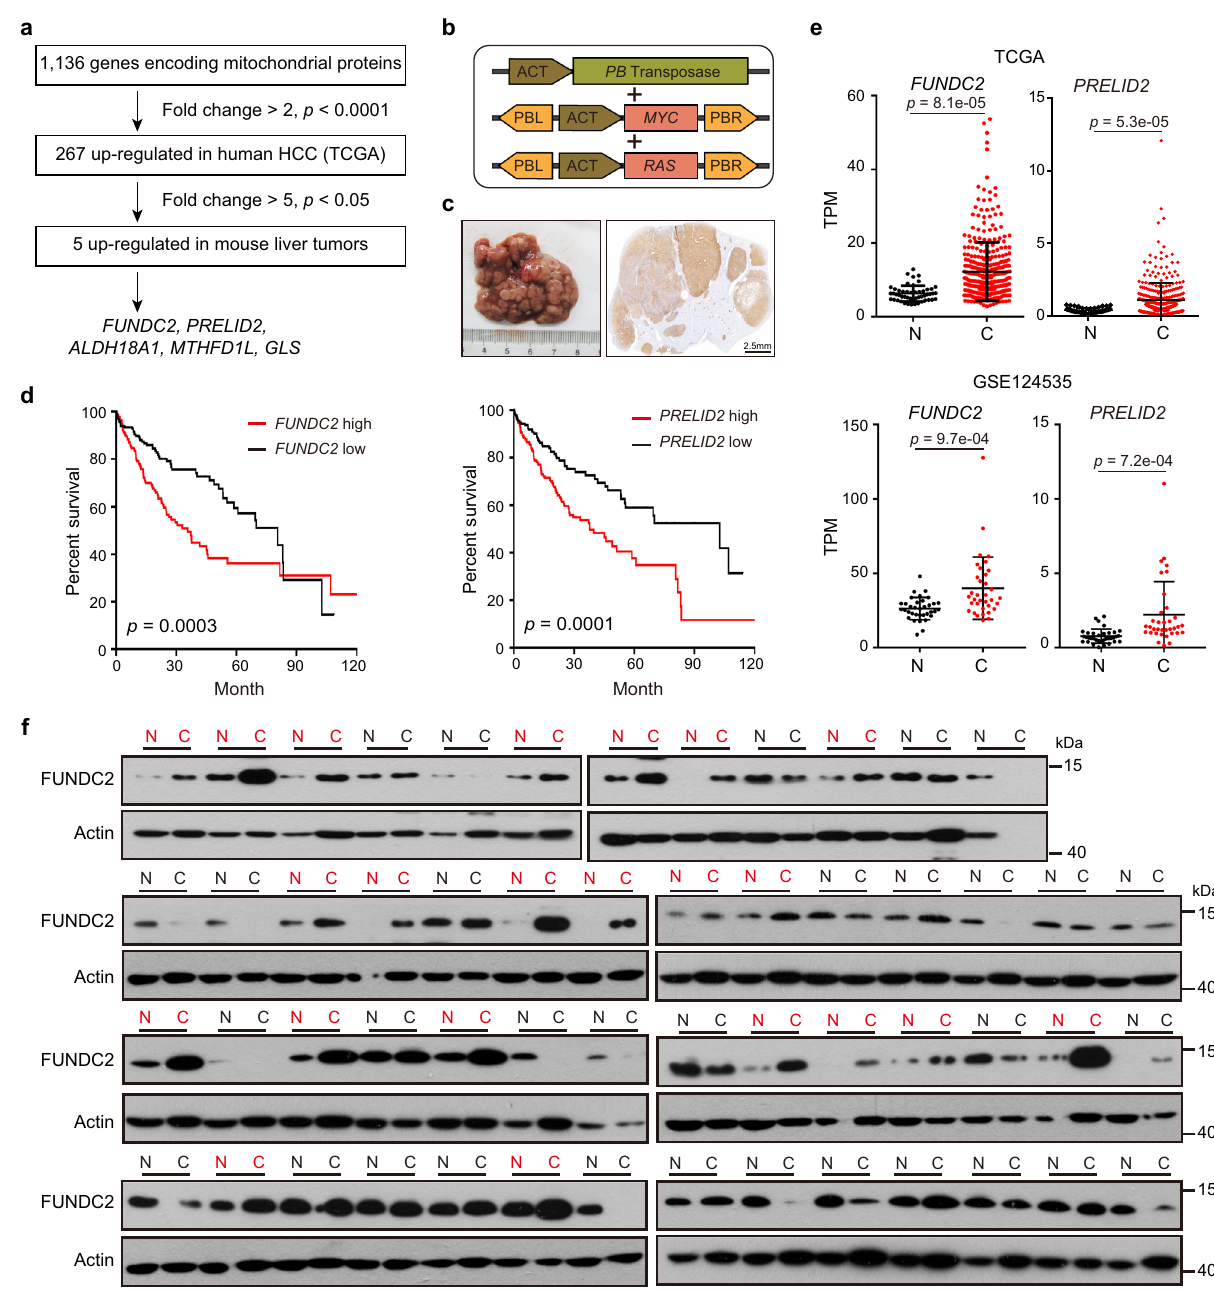
Fig. 1 FUNDC2 is upregulated in human HCC. a Flowchart of screen for transcriptionally dysregulated mitochondrial protein. b Illustration of plasmids used for in vivo genome editing of hepatocytes. c Representative mouse liver tumors induced by MYC + RAS , and IHC staining of a respective liver section by anti-HA antibody on the right. d Kaplan – Meier plots of overall survival for FUNDC2 or PRELID2 expression levels. The median expression levels were used as a cut-off. e FUNDC2 and PRELID2 mRNA levels in the TCGA and GSE124535 cohorts of HCC. Data are presented as mean ± SD. f FUNDC2 protein levels in HCC (C) and adjacent normal (N) samples were revealed by western blotting. This experiment was repeated twice. Red indicates pairs with increased FUNDC2 in cancer (>2) as determined by Image J quanti fi cation of relative protein levels. p values were calculated by two-tailed unpaired Student ’ s t -test. Source data are provided as a Source data fi